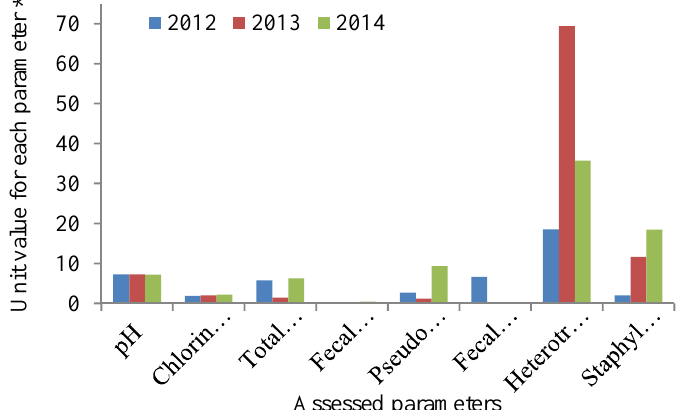
Fig. 1. Trends in the variation of parameters assessed during the study period. ( * Measurement units: pH: no unit; Chlorine residual: mg/L; TC and FC: MPN/100mL; Pseudomonas aeruginosa and HPC: cfu/mL; Fecal Streptococci and S. aureus: